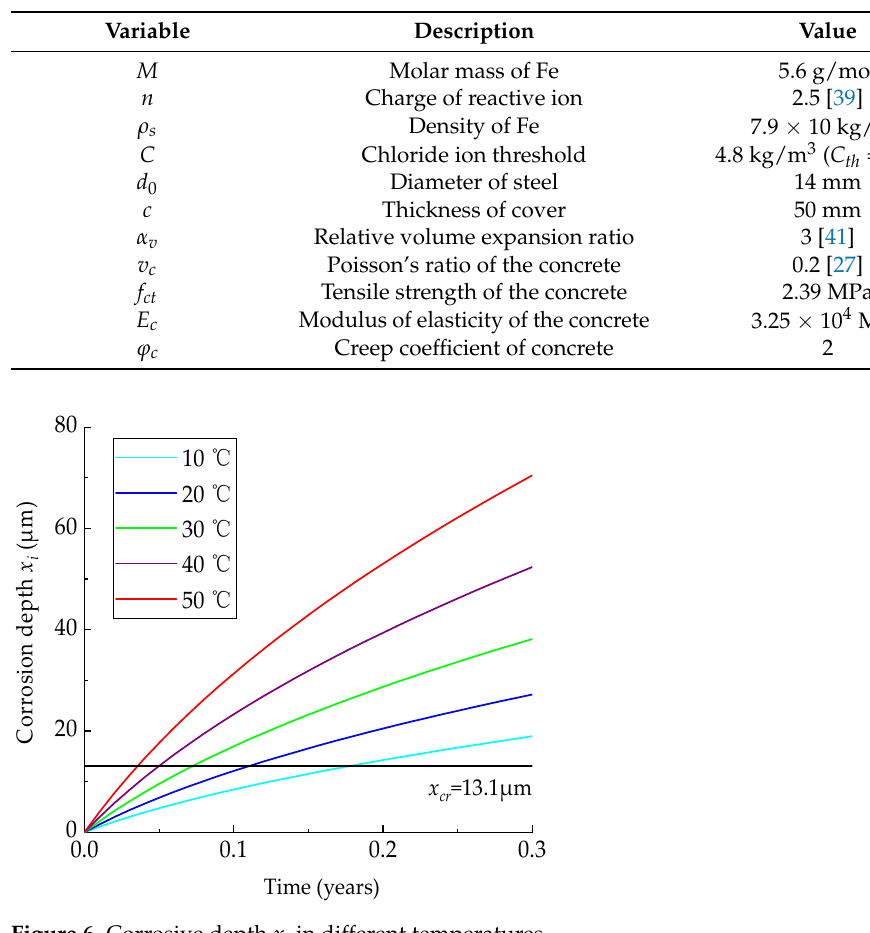
Table 3. Variables in t 2 Computation.